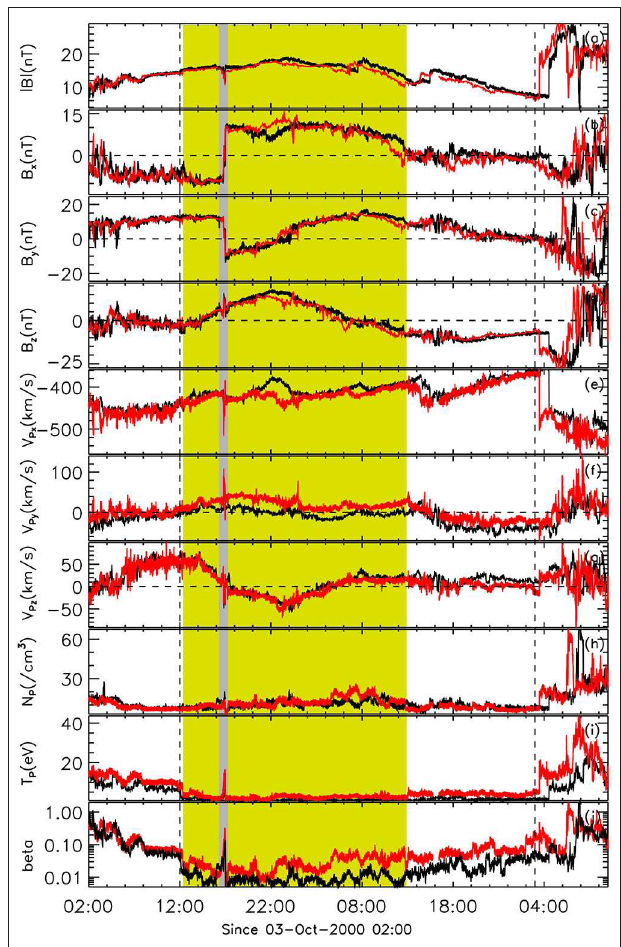
FIGURE 1 | Measurements of ACE (black) and Wind (red) from 02:00 UT on Oct 03 to 11:00 UT on Oct 05, 2000. The observations of ACE have been shifted 110min for forward. (a–d) Magnitude and three components of the magnetic field. (e–g) Three components of plasma velocity. (h–j) Proton density, temperature and proton plasma beta values. The two vertical dashed lines indicates the boundary of the ICME. the two orange regions denote the two merging flux ropes. The shadow region denotes the reconnection current sheet intermediating the